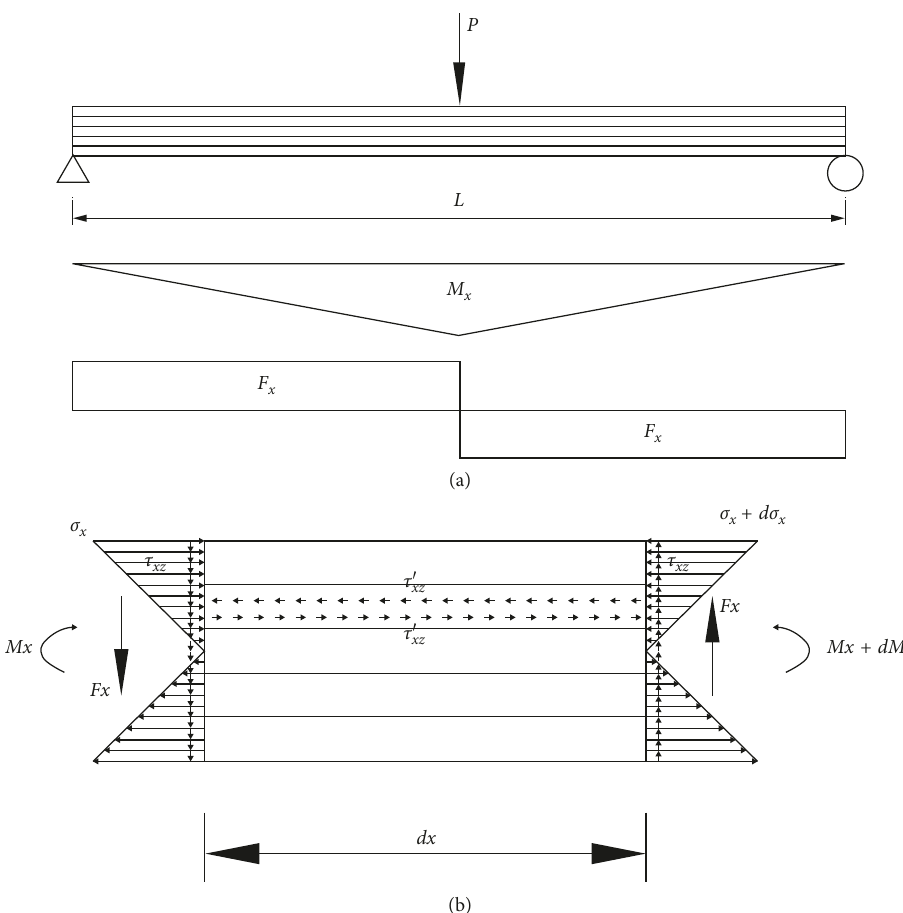
Figure 5: Loads and flexural stress distributions of three-point loading laminated beam. (a) Bending moment and shear force distribution. (b) Stress distribution of infinitesimal